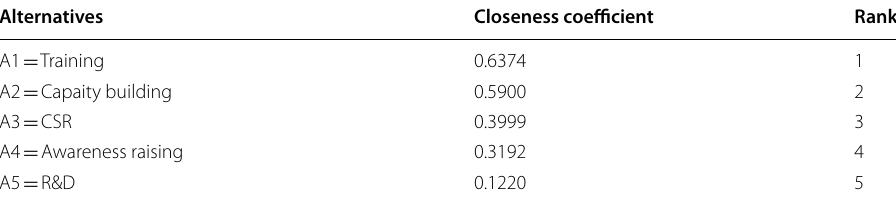
Table 20 Top Alternatives in the human factor criterion